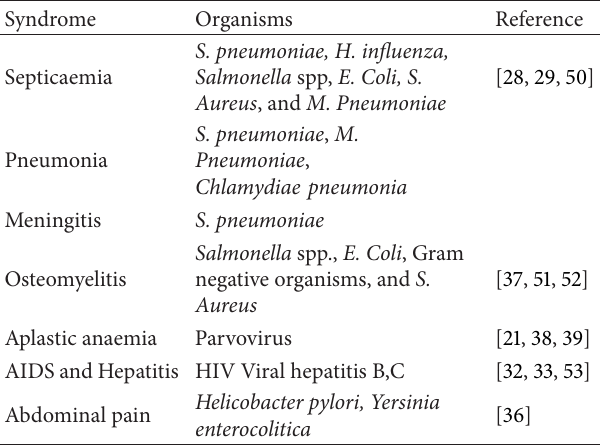
Table 1: Clinical syndromes and common causative organisms re- ported in